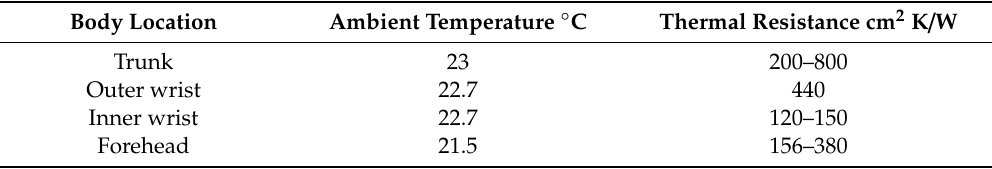
Table 4. Thermal resistance measurements measured at various body